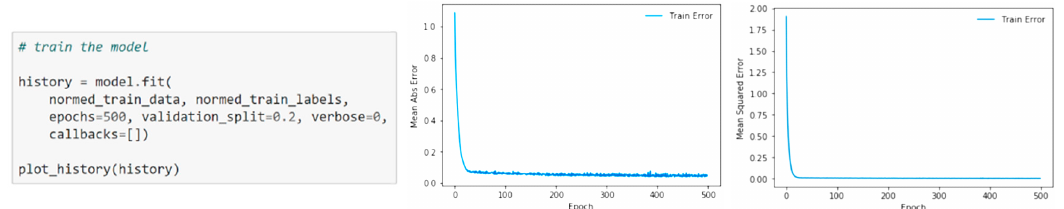
Figure 8. Running the training process using the linear regression algorithm.